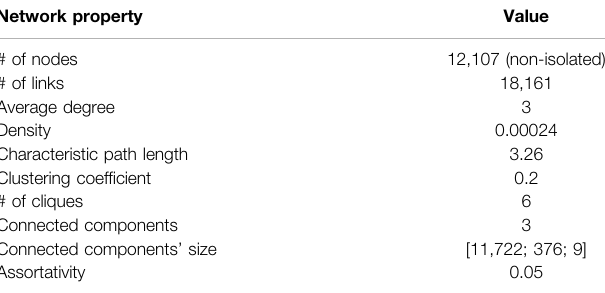
TABLE 2 | Summary statistics of the full network. Network properties are assessed at a network (global) and node (local) level. Network property